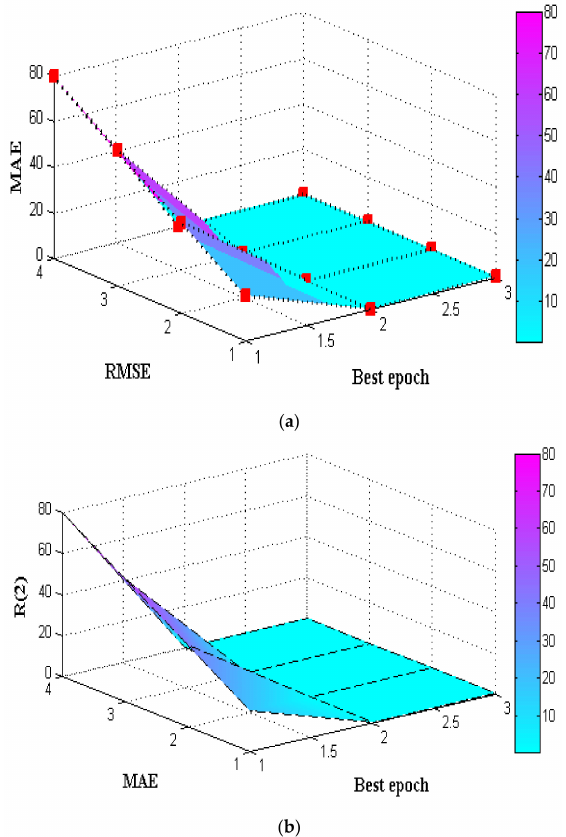
Figure 10. Comparison of errors ( a ) RMSE vs. MSE ( b ) MAE vs. R 2 .